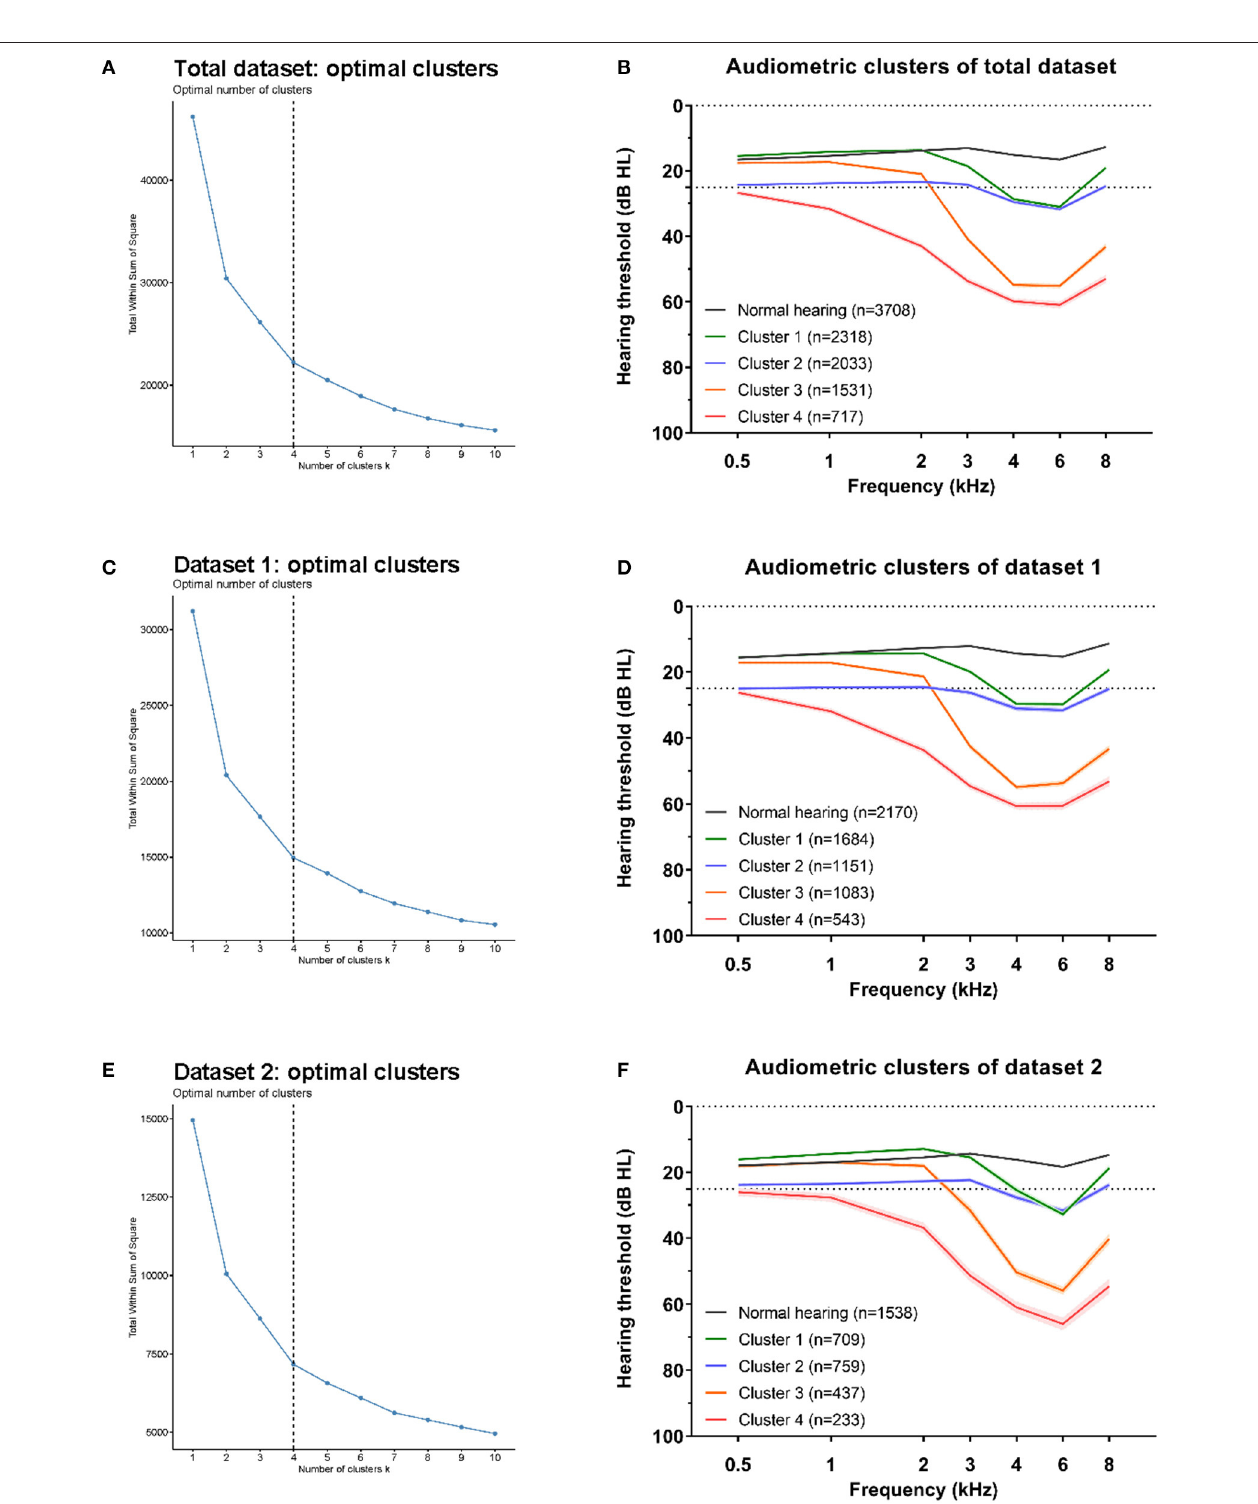
FIGURE 2 | Optimal clusters for three datasets. The within cluster sum of squares (WSS) decrease with the increment of clusters number, and the optimal number of clustering was selected at the last one significantly reduced the WSS (at the inflection point of the curve). The optimal clustering were all at number of four (black dotted line) for total dataset (A) , dataset 1 (C) , and dataset 2 (E) . The average hearing thresholds over 0.5–8kHz frequencies of normal hearing subjects and those four clusters were shown for total dataset (B) , dataset 1 (D), and dataset 2 (F) .